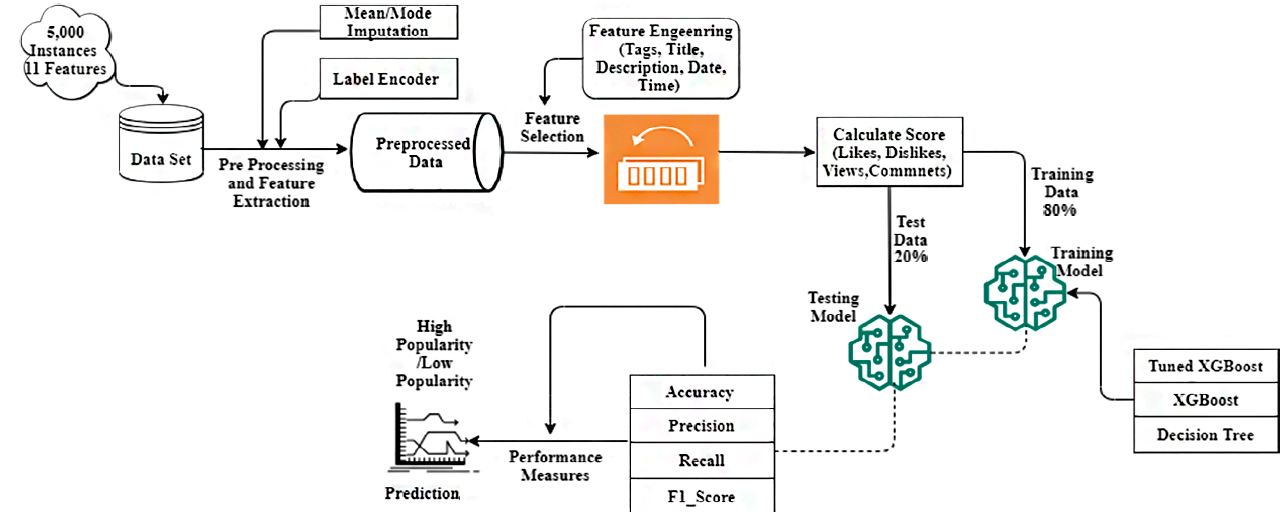
Figure 1. Conceptual workflow optimizing YouTube video popularity.